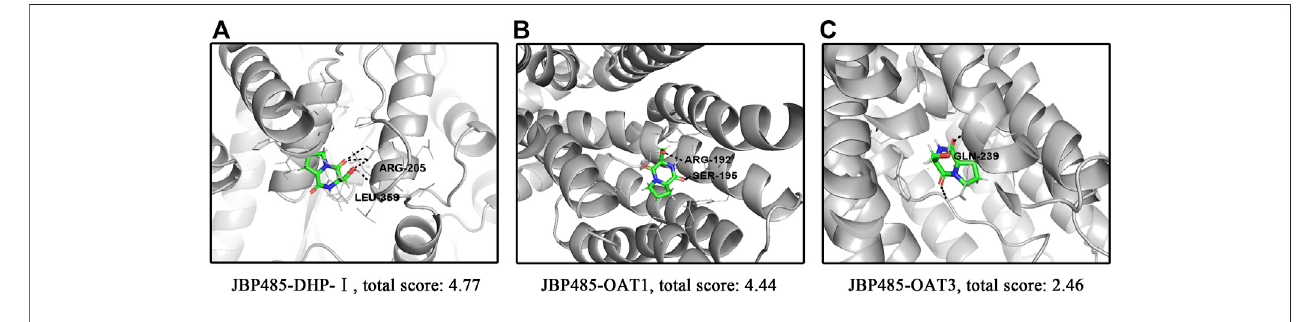
FIGURE 6 | Molecular docking simulation between JBP485 and DHP-I (A) , OAT1 (B) or OAT3 (C) .